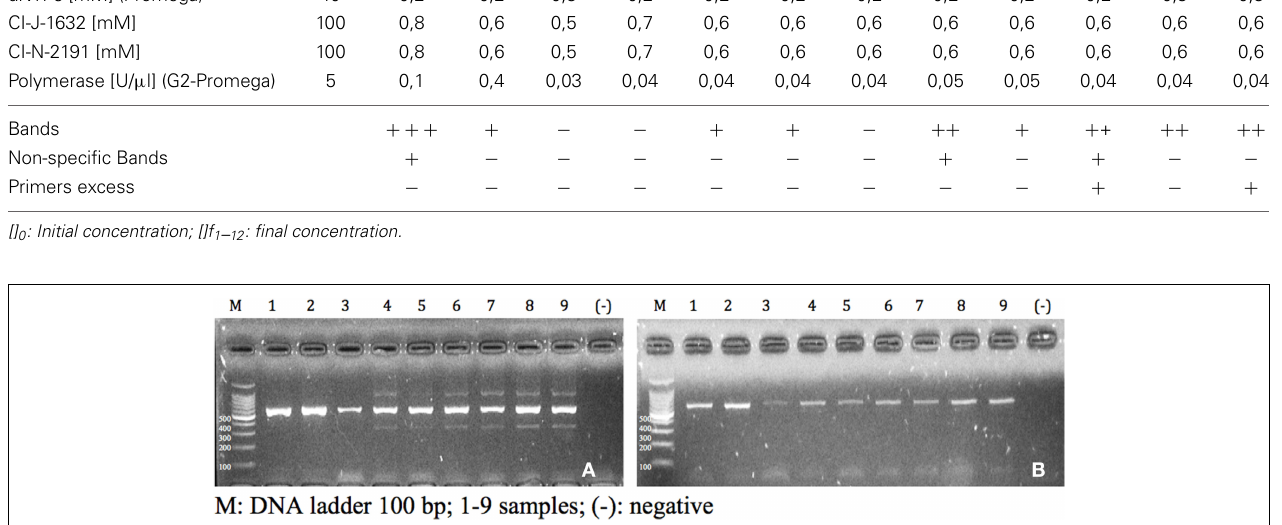
FIGURE 1 | Amplicons visualized in agarose gel of 2% (w/v) of samples of Cochliomyia spp., collected in Pichincha-Ecuador. (A) f 1 concentration; (B) f 2